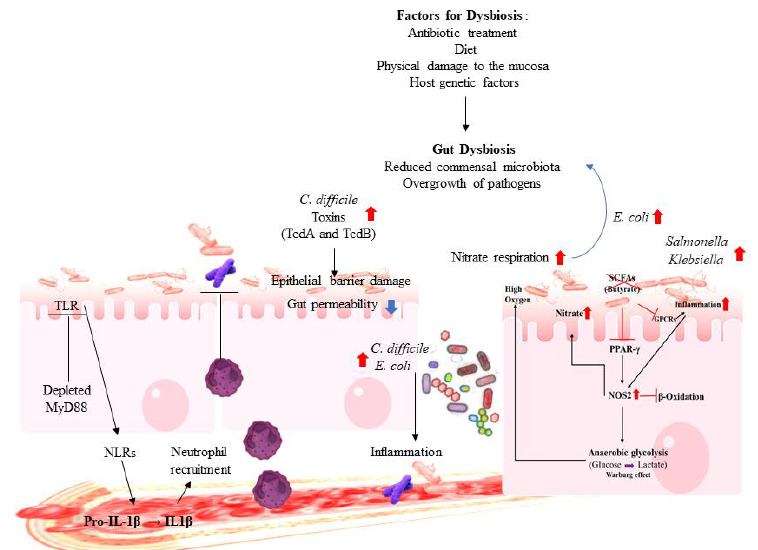
Figure 2. Gut dysbiosis. Multiple factors including diet, antibiotic treatment, and host genetic can interrupt the community of commensal microbial, resulting in increased colonization by pathogens and the outgrowth of indigenous pathobionts, such as Clostridium difficile . C. difficile can produce toxins, such as TcdA and TcdB, that destroy the epithelial barrier and increase gut permeability. Increased systemic inflammation occurs with a systemic circulation of bacteria related to toxin-mediated epithelial damage. Pathogen-induced gut inflammation grants growth benefits to pathogenic bacteria through the production of inducible nitric oxide synthase (iNOS), which is later metabolized by the host innate immune cells resulting in the release of nitrate (NO 3− ), which can be consumed by Escherichia coli and processed through nitrate respiration to generate energy. The infection of pathogenic bacteria causes the changing of proIL-1β into the enzymatically active form of IL-1β, activating neutrophil recruitment and pathogen removal. NLRP3 inflammasome is stimulated via bacterial toxins, subsequently inducing caspase-1 proteolytic activation, which results in released biologically active IL-1β and IL-18. Arrows represent increases (red) and decreases (blue) in bacterial abundances, metabolites and downstream effects observed in the antibiotic treated dysbiotic gut.